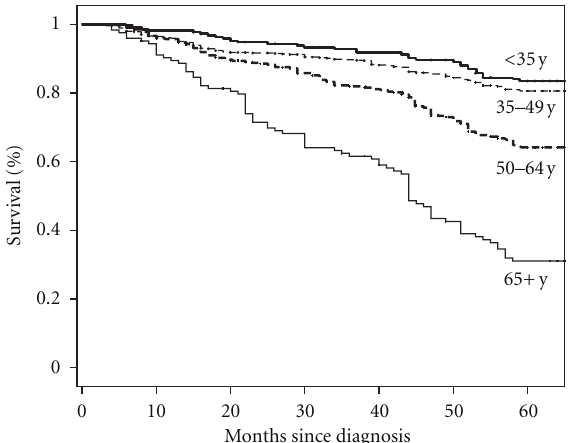
Figure 1: Kaplan-Meier survival curves for breast cancer patients in Iran for four age groups at